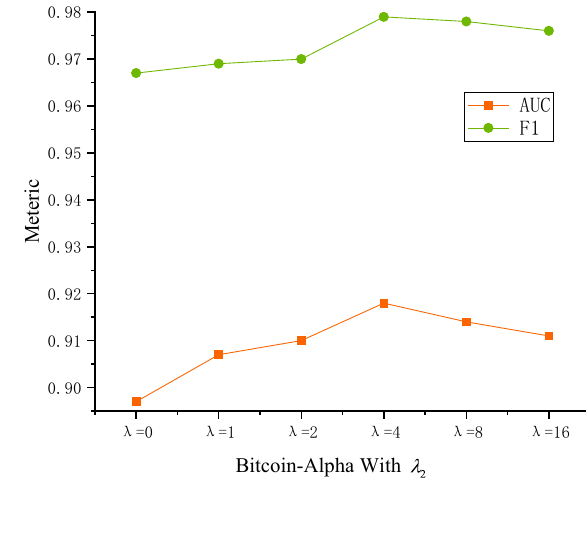
Fig. 6 Various values of 𝜆 1 and 𝜆 2